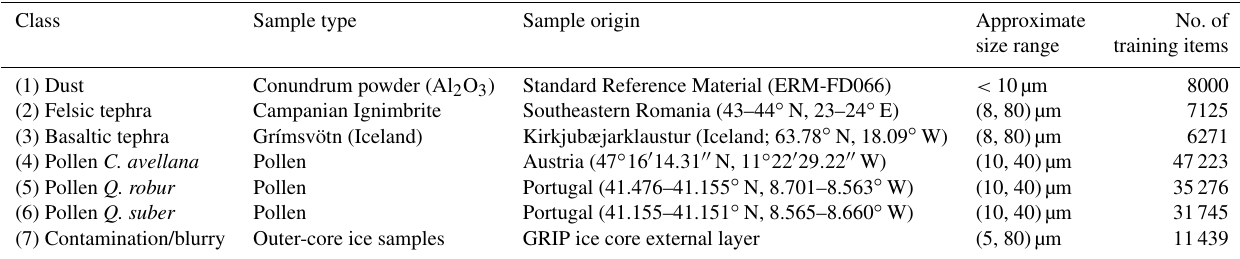
Table 1. Training